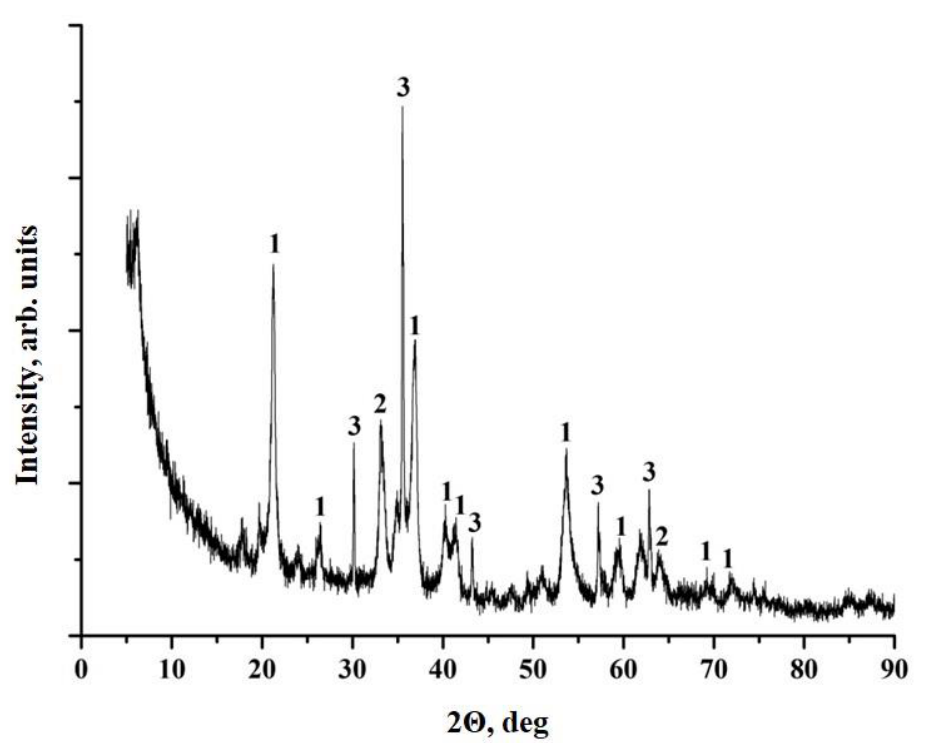
Figure 5. XRF pattern of ocher particles: 1—FeO(OH) goethite; 2—Fe 2 O 3 hematite; 3—Fe 3 O 4 magnetite.